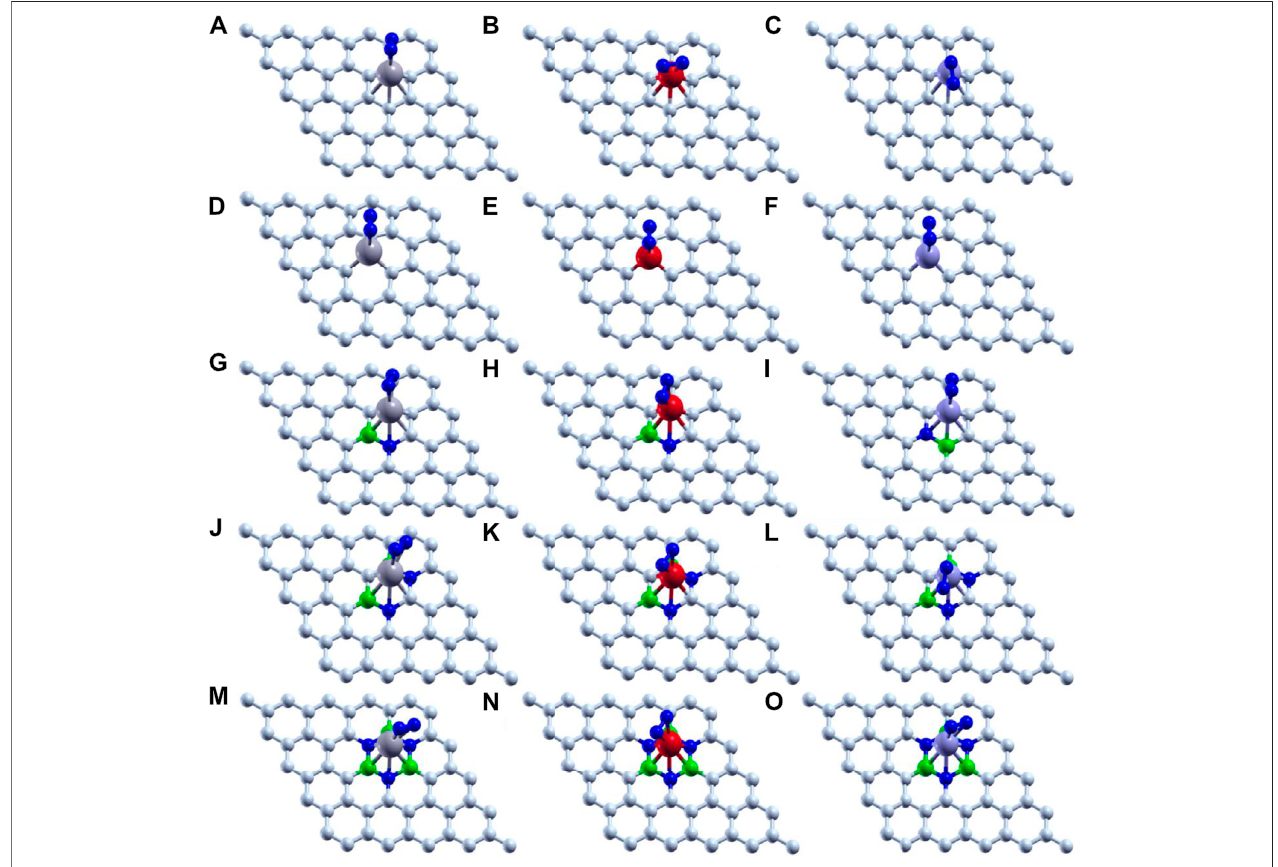
FIGURE 4 | Optimized structure of the N 2 molecule adsorbed on Mo (gray), Fe (red), and V (purple) on various supports: (A – C) pristine graphene, (D – F) defective graphene, (G – I) BN-doped graphene, (J – L) BNC-ring graphene, and (M – O) BN-ring graphene.